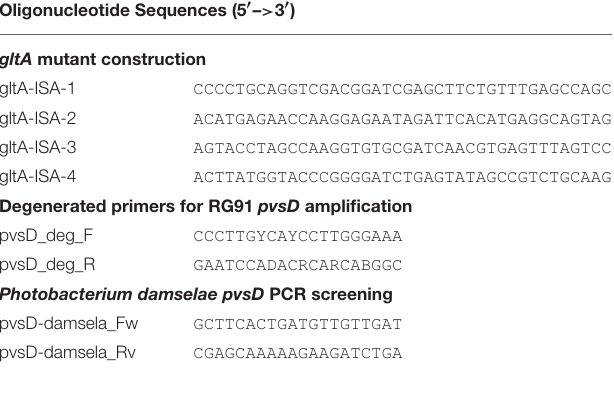
TABLE 2 | Oligonucleotides used in this work for mutant construction and detection of pvsD gene by PCR. Oligonucleotide Sequences (5 ′ – > 3 ′